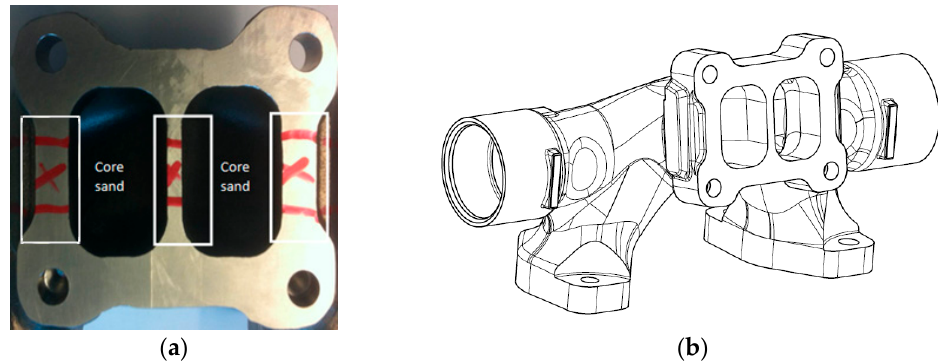
Figure 1. HK30 cast stainless steel turbo manifold; ( a ) location of sample removal; ( b ) 3D CAD (Computer-aided design) drawing of turbo manifold. Table 1. Chemical composition of austenitic stainless steel HK30 (wt %).